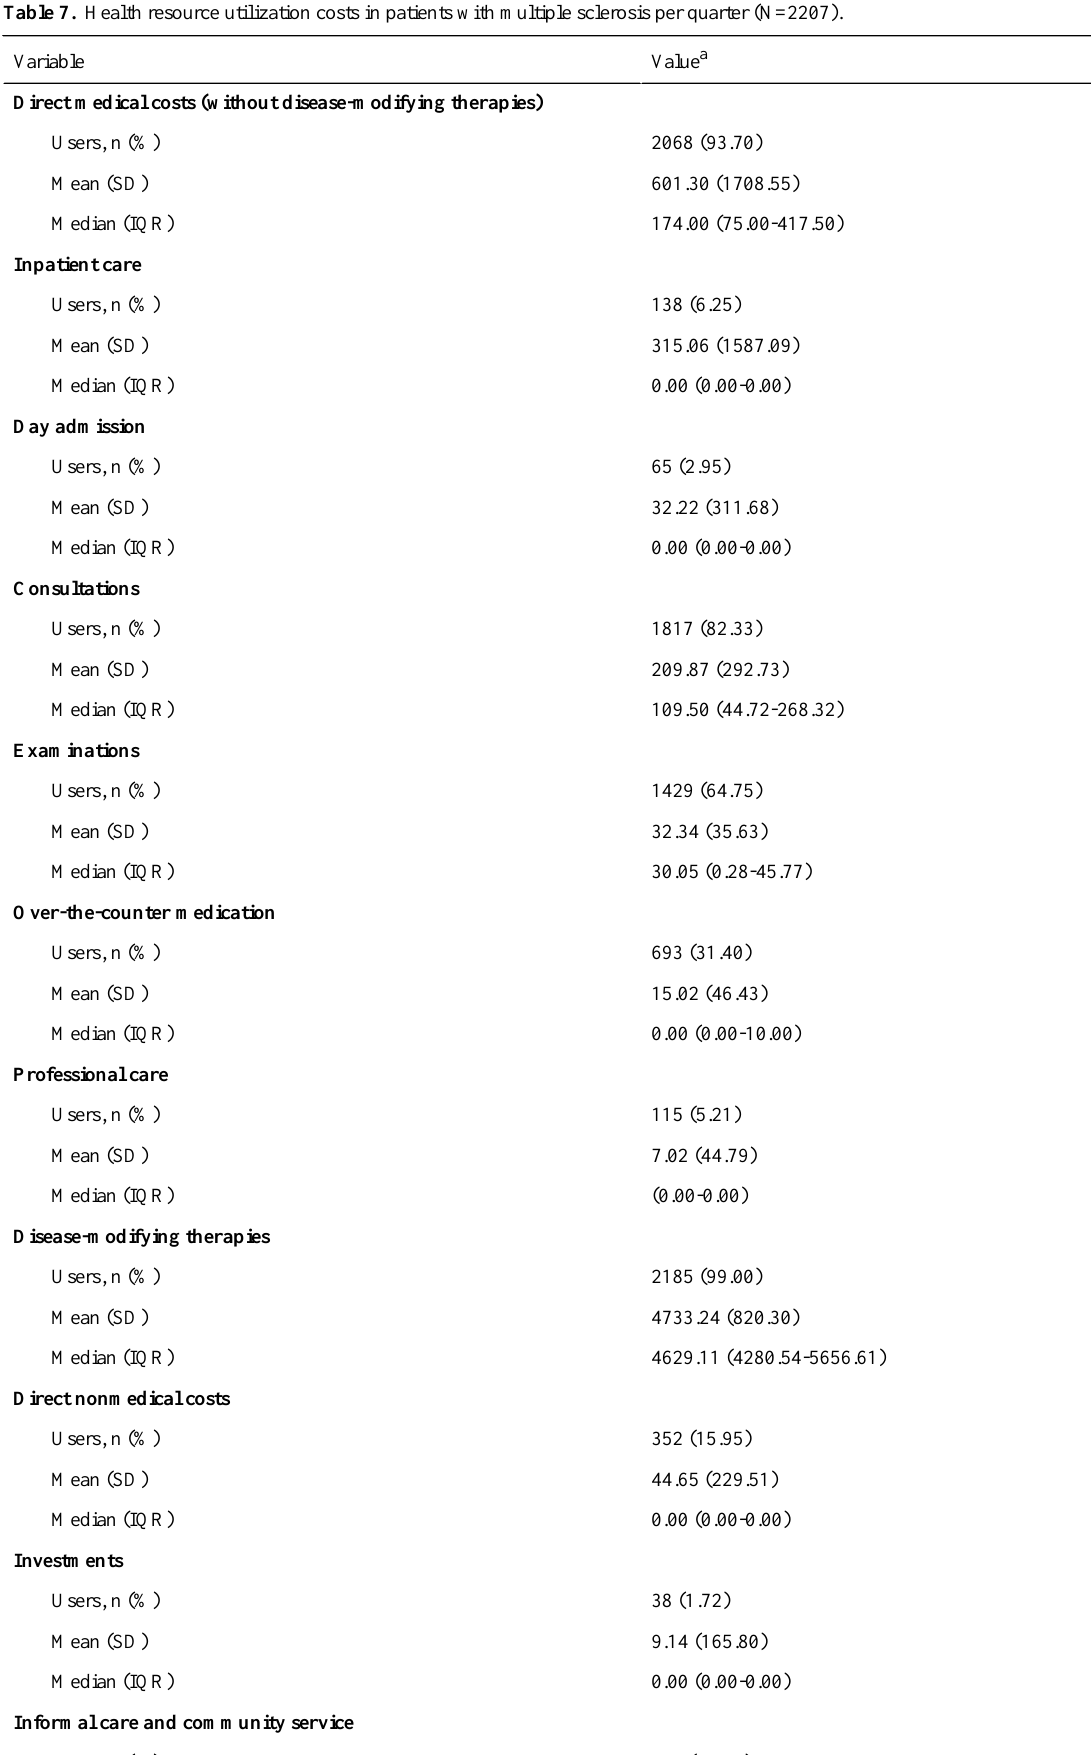
Table 7. Health resource utilization costs in patients with multiple sclerosis per quarter